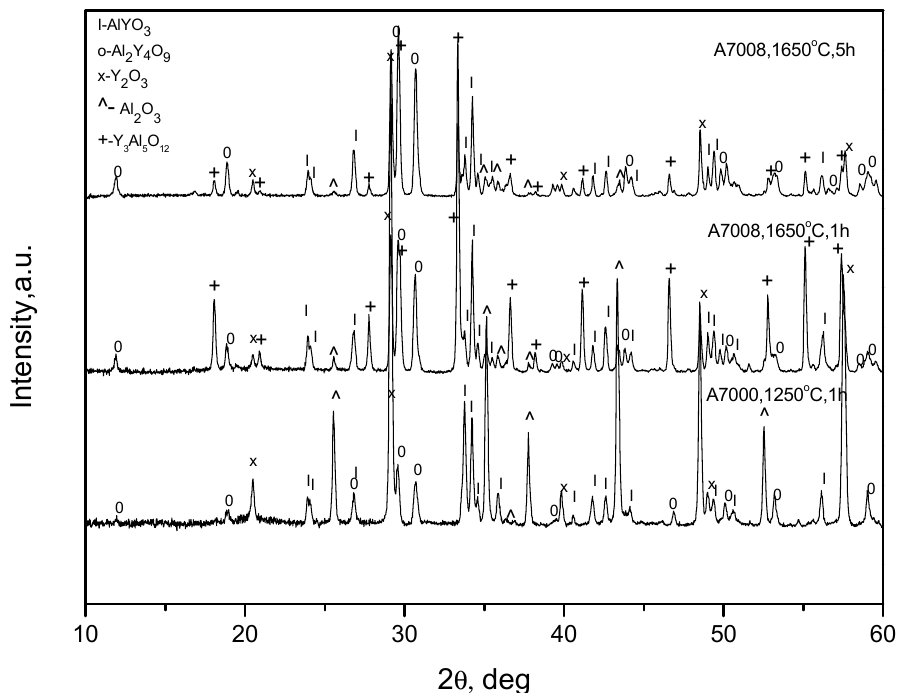
Figure 1. X-ray spectra of the oxide blanks sintered in various temperature / time regimes. Table 1. Approximate phase compositions of the oxide blanks sintered in various temperature / time regimes. Sintering Regime Phase Composition in vol % Temperature/°C Time/h